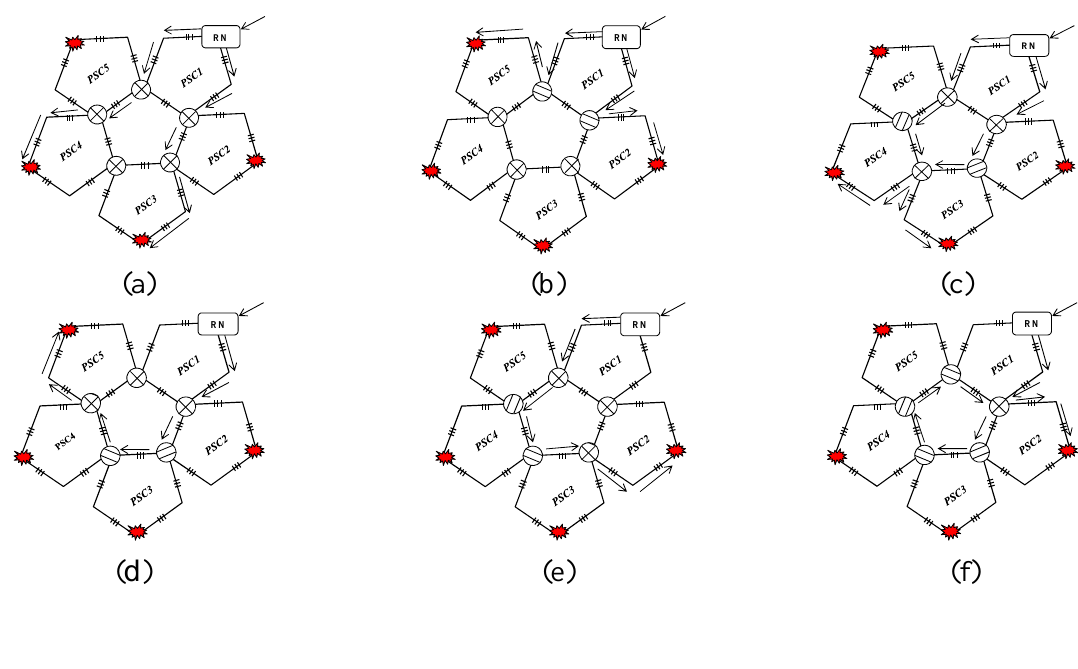
Figure 7. (a) Four link failures; (b) Self-healing 1; (c) Self-healing 2; (d) Self-healing 3; (e) Self-healing 4; (f) Self-healing